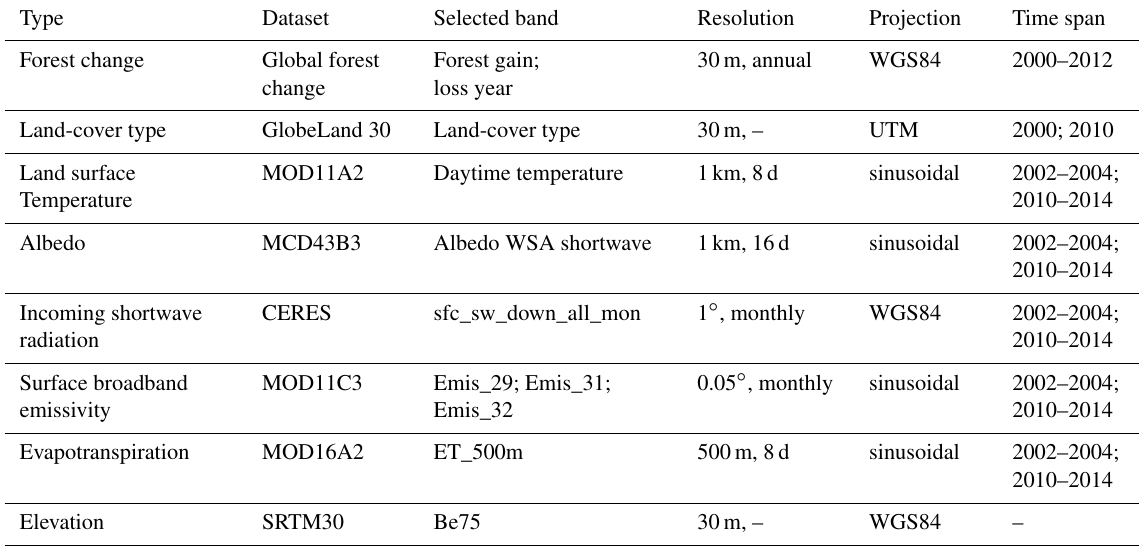
Table 1. Summary of the datasets and their main characteristics.